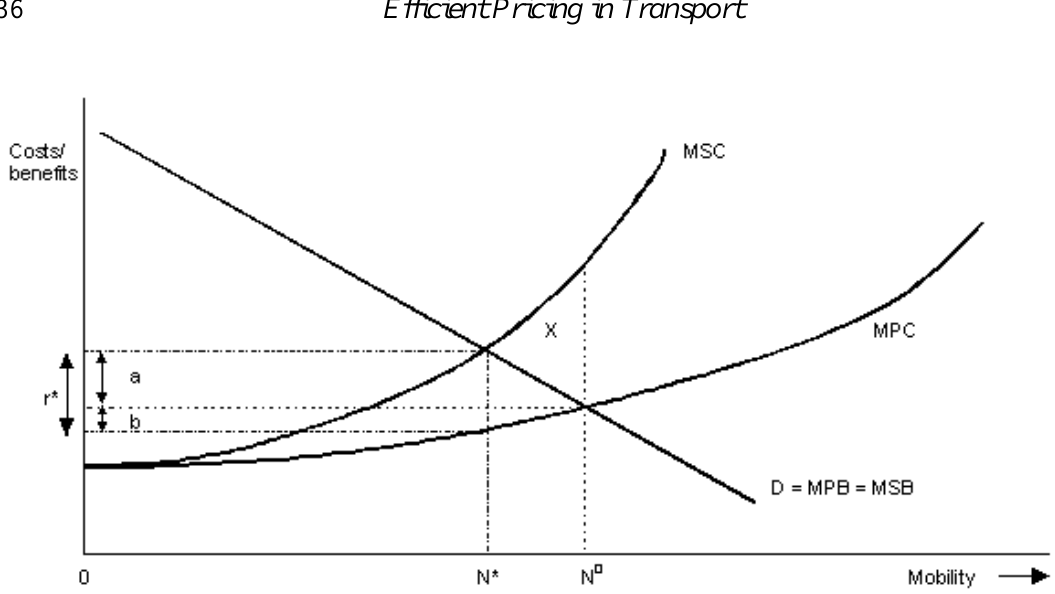
Figure 2. Effects of congestion charges in road